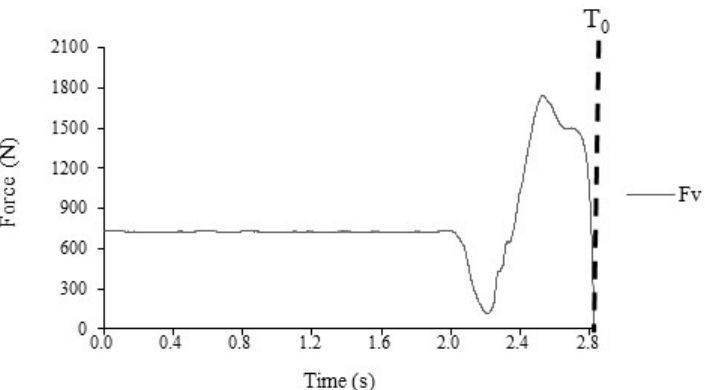
Figure 3. Exemplar vertical force–time profile during quiet standing and takeoff of CMJ without arm-swing.